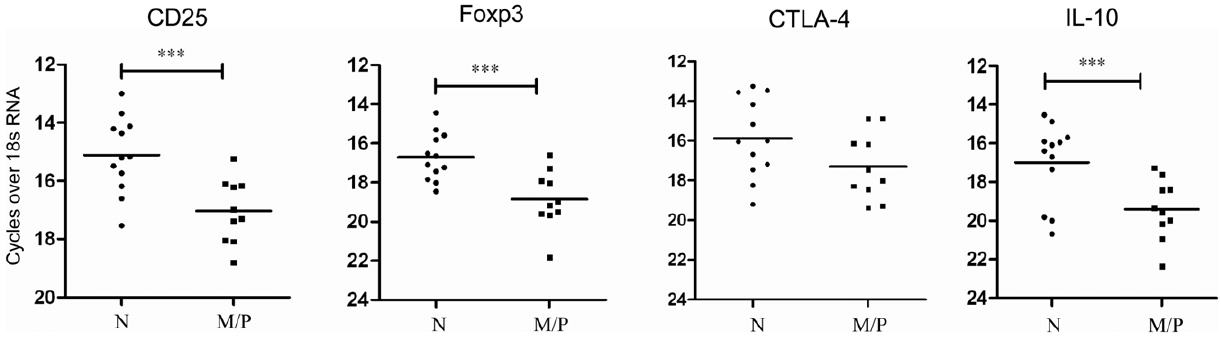
Figure 4. Ex vivo analysis of mRNA expression in different clinical manifestations of PKDL. Ex vivo analysis of relative Treg markers and IL- 10 mRNA levels in Nodular (N) (n=12) and Macular/Papular (M/P) (n=10) lesions in distinct forms of PKDL. ***P ,